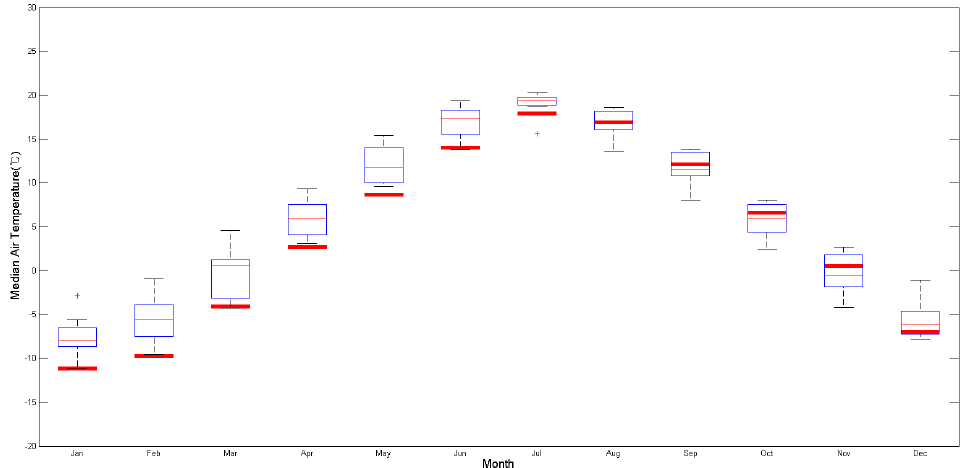
Figure 7. Boxplot of monthly median air temperature from 2020 to 2096 years for RCP 8.5 with 12 climate models; bold red line indicates monthly median air temperature for the observed period (2011 to 2014) and other results for RCP 2.6 (Figure S2) and RCP 4.5 (Figure S3) are in Supplementary Materials.